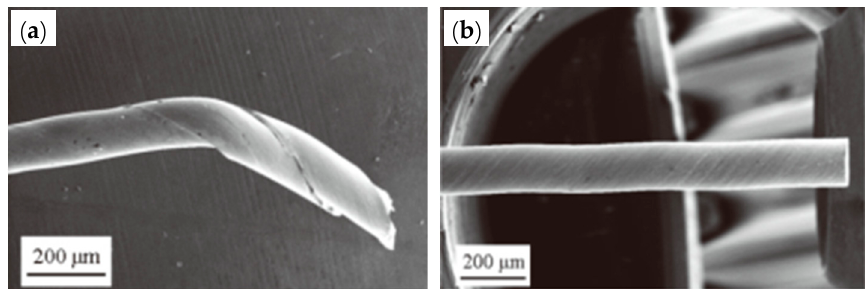
Figure 21. Fractures of steel wire in torsion: ( a ) galvanized steel wire and ( b ) hot-dip galvanized monofilament. Reprinted with permission from ref. [36].